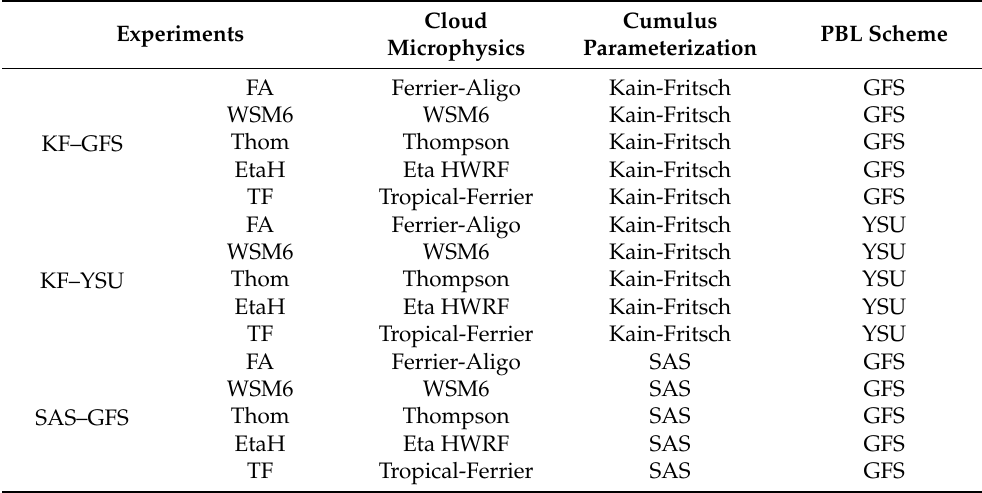
Table 1. Physics-sensitivity experiments for both supertyphoons approaching the northern